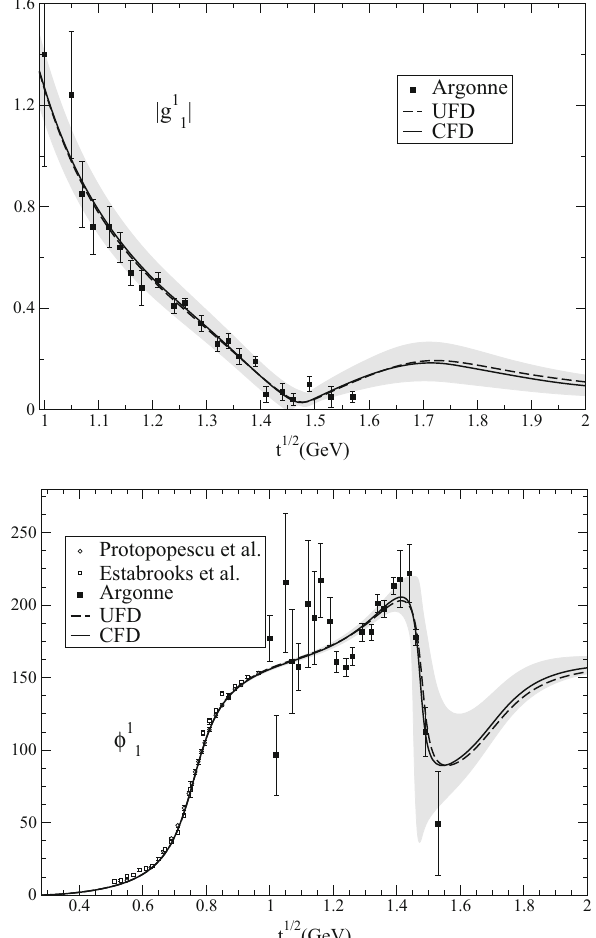
( t ) ππ → K ¯ K partial wave. Fig. 9 Modulus and phase of the g 1 1 The continuous line and the uncertainty band corresponds to the CFD whereas the dashed line corresponds to the UFD. The white circles and squares come from the ππ scattering experimental analyses of Protopopescu et al. [2] and Estabrooks et al. [4],